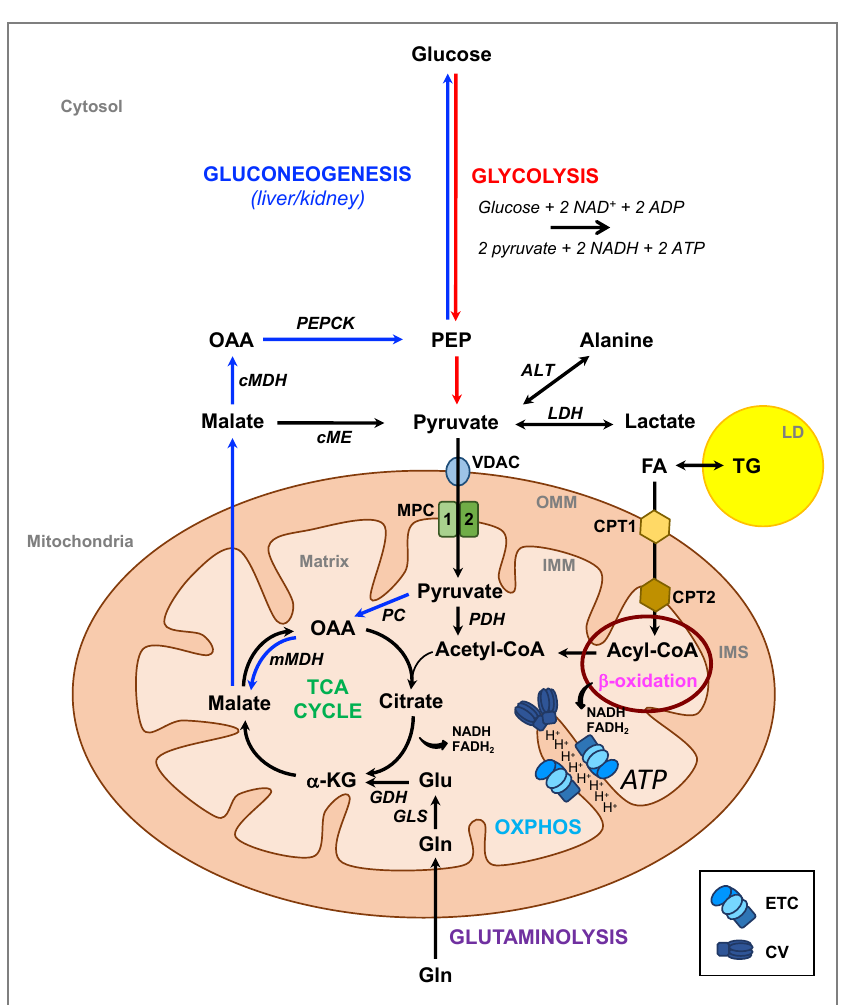
Figure 1. Metabolic pathways involving mitochondria. In the cytosol, pyruvate is produced through Figure 1: Metabolic pathways involving mitochondria. glycolysis, which generates two adenosine triphosphate (ATP) and two reduced nicotinamide adenine dinucleotide (NADH) molecules per molecule of glucose. Pyruvate can also be produced from oxidation of lactate by lactate dehydrogenase (LDH), conversion from alanine by alanine transaminase (ALT), or from malate by cytosolic or mitochondrial malic enzyme (ME). Pyruvate can be imported into mitochondria to be oxidized into acetyl coenzyme A (acetyl-CoA) by the pyruvate dehydrogenase (PDH), which then fuels the tricarboxylic acid (TCA) cycle. Import of pyruvate requires the voltage-dependent anion channel (VDAC) to cross the outer mitochondrial membrane (OMM) and the mitochondrial pyruvate carrier (MPC) to cross the inner mitochondrial membrane (IMM). The TCA cycle can also be fueled by glutamine (Gln) through glutaminolysis or by fatty acids (FA) released from lipid droplets (LD) where they are stored in the form of triglycerides (TG). FAs provide acetyl-CoA through FA β -oxidation. The TCA cycle and β -oxidation both generate the reducing equivalents NADH and flavin adenine dinucleotide (FADH 2 ), which transfer electrons to the electron respiratory chain (ETC), generating more than 30 ATP molecules per molecule of glucose. The last reaction is catalyzed by ATP synthase or Complex V (CV). This process requires the presence of oxygen and is known as oxidative phosphorylation (OXPHOS). In the liver and kidney, pyruvate can be converted into oxaloacetate (OAA) by the pyruvate carboxylase (PC), which is then reduced into malate by the malate dehydrogenase (mMDH). Malate is then exported into the cytosol, converted into OAA by malate dehydrogenase (cMDH) and into phosphoenolpyruvate (PEP) by PEP carboxykinase (PEPCK) and from there into glucose through several steps, including the reversible steps of glycolysis. IMS: intermembrane